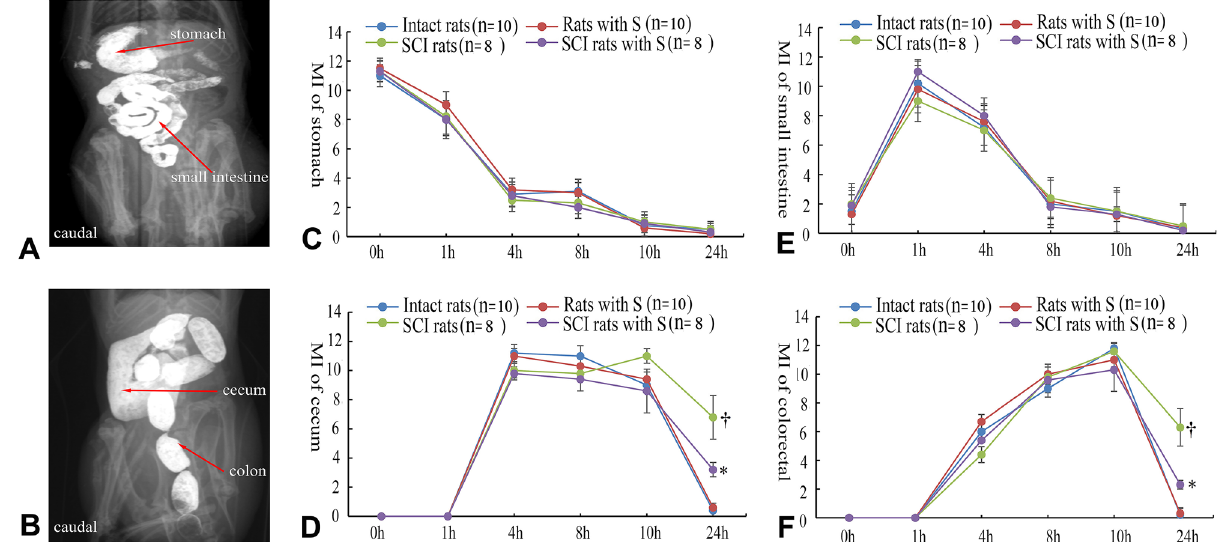
Figure 3. Barium imaging and Motility index (MI) of digestive tract. ( A ) and ( B ) Division of digestive tract, from an intact rat. ( C – F ) MI of digestive tract at four weeks after surgery, *SCI rats with S vs SCI rats, † SCI Rats vs Intact Rats, P < 0 ⋅ 05 (two-way ANOVA). In the semi-quantitative analysis, the total score was 12, higher scores and rapidly changes indicate more motility. MI showed the differences in the colon between SCI rats with S and SCI rats.